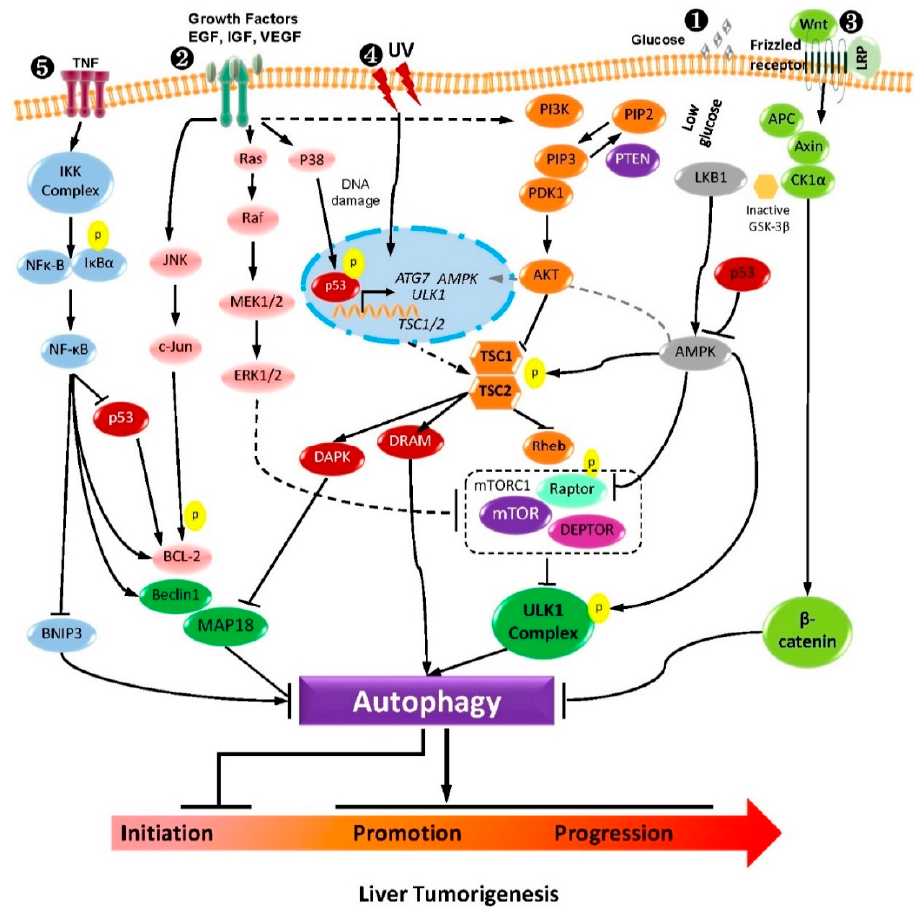
Figure 2. The crosstalk between the major signaling pathway regulating autophagy and liver tumorigenesis. (1) PI3K-AKT-mTOR and AMPK-mTOR pathway receptor tyrosine kinases